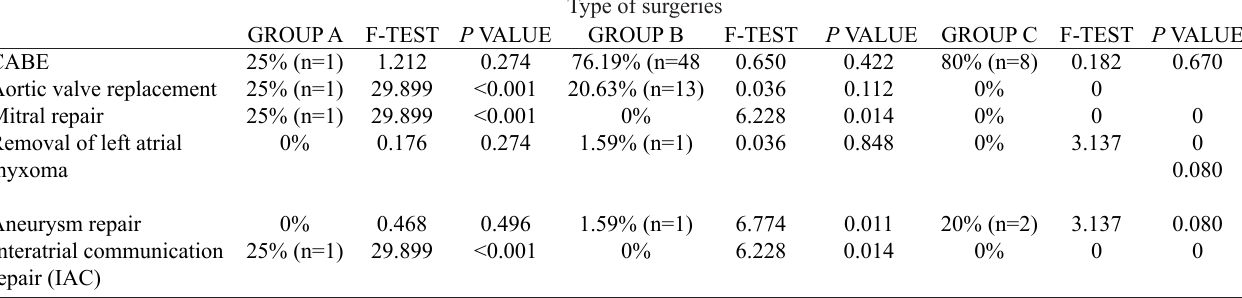
Table 1. Type of surgeries.